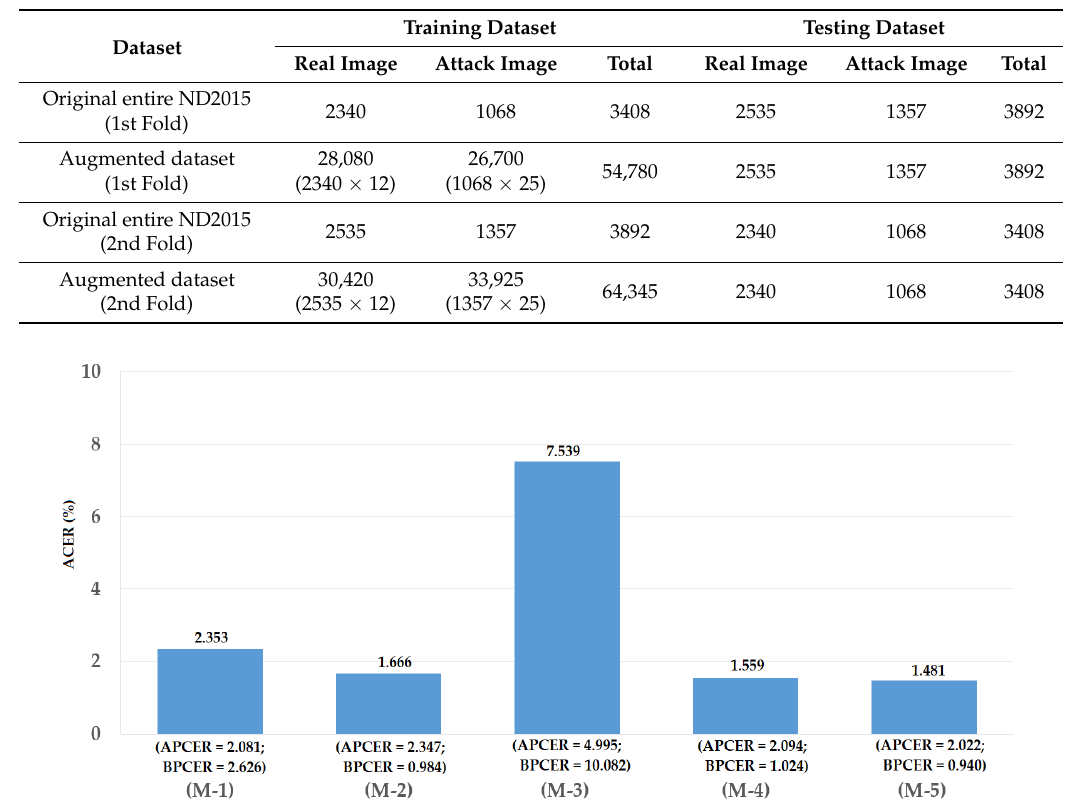
Table 7. Description of training and testing data used for entire ND2015 dataset.